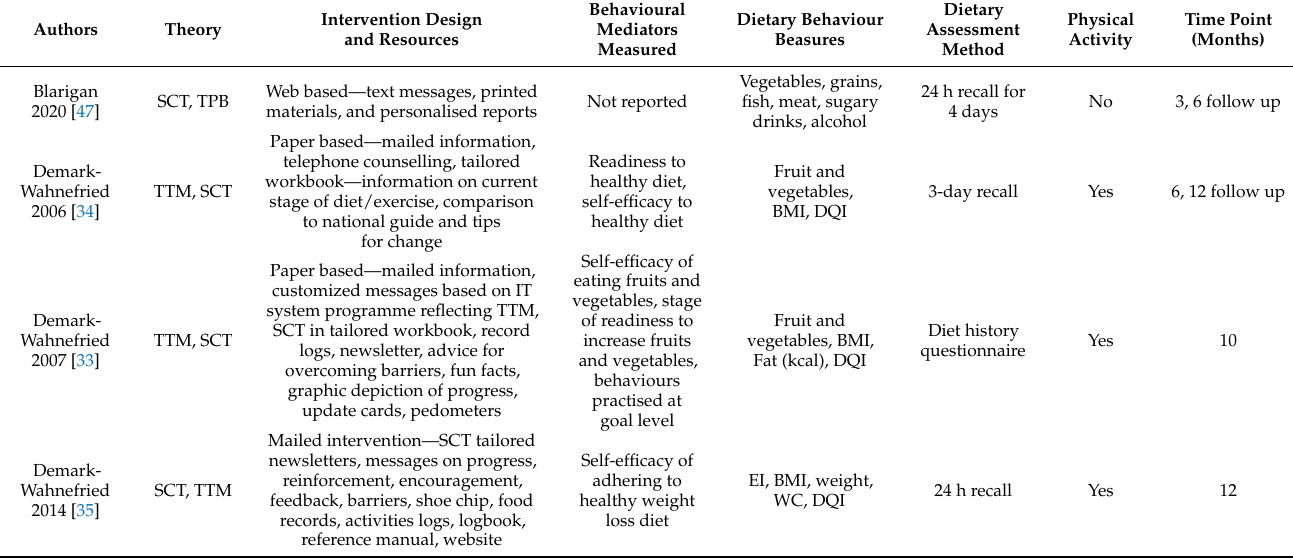
Table 2. Characteristics of the